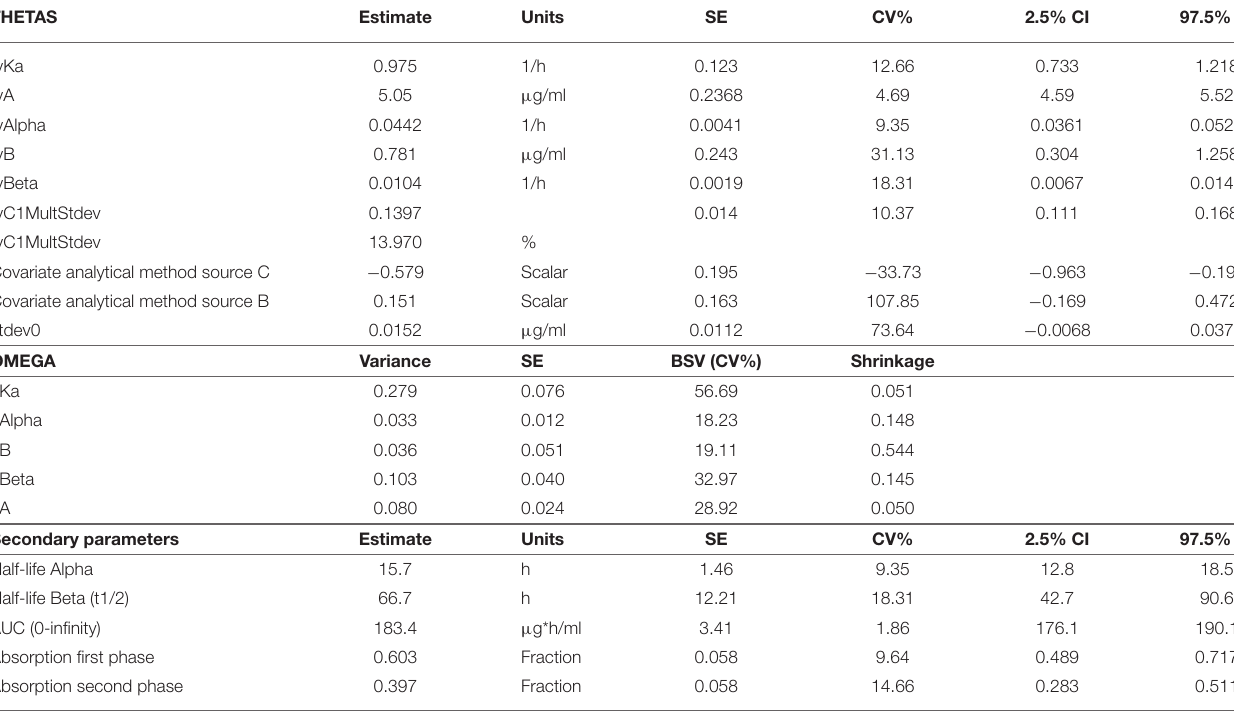
TABLE 2 | Population primary (Thetas) and secondary parameters and random effects (Omega) for florfenicol in calves obtained with a 2-compartment